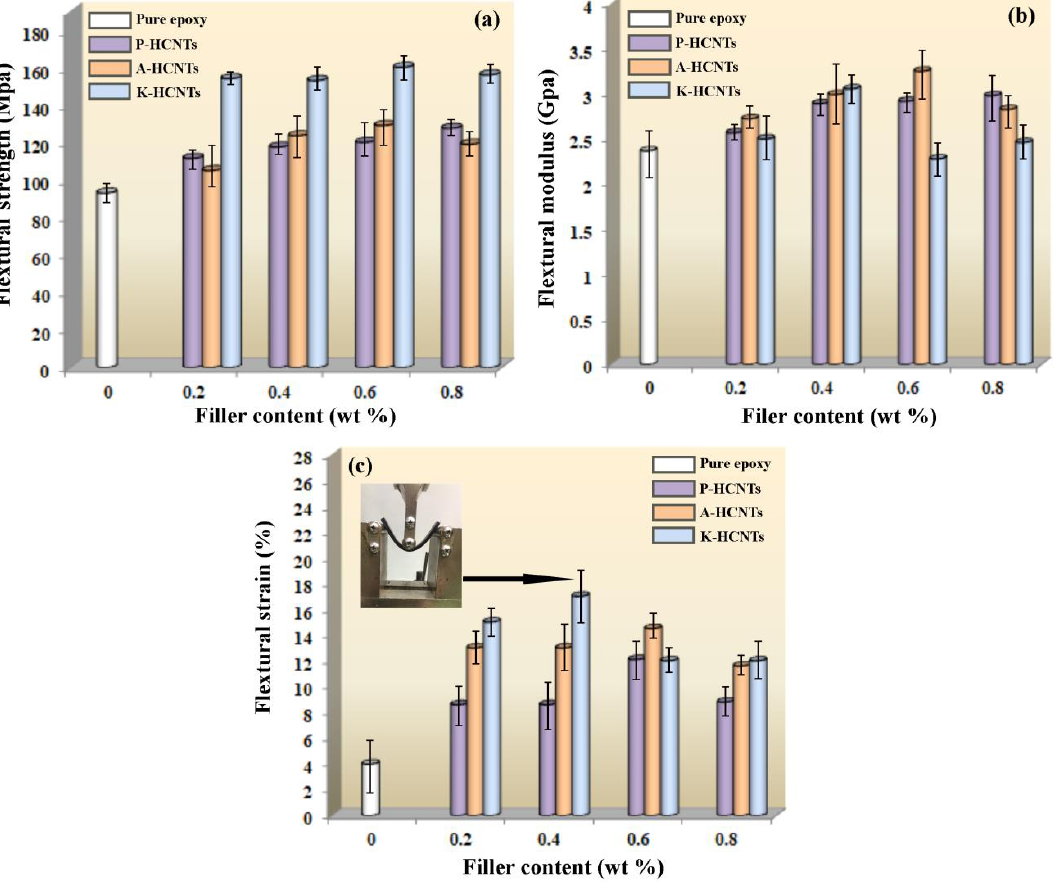
Figure 5. Flexural strength ( a ) and flexural modulus ( b ) and flexural strain ( c ) of pure epoxy, untreated HCNT/epoxy and surface-treated HCNT/epoxy composites as a function of HCNT content; the inset is an optical image exhibiting the high flexural strain of K-HCNT/epoxy composites during the bending test.